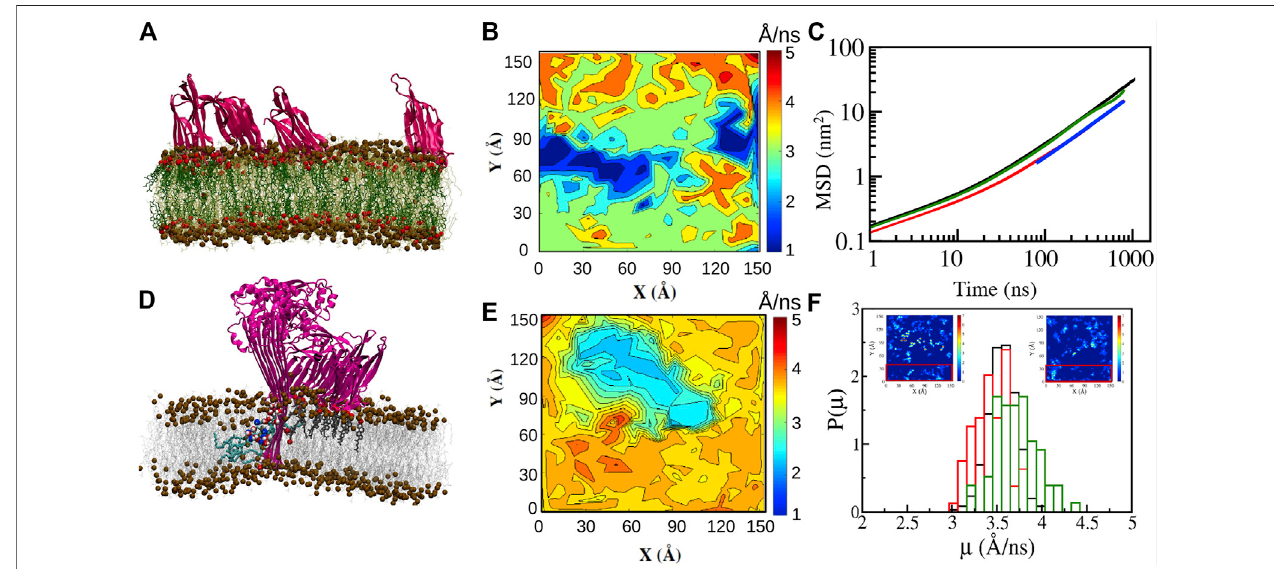
FIGURE 9 | AllatomsimulationsofLLOonDOPC:Chol(70:30)bilayers. (A) Snapshot(1 µs)offourD4membraneboundsubunits(pink).Cholesterol(dark greenwith redOHgroups),DOPC(lightgreen).DistinctcholesterolsequestrationisvisiblebelowtheD4subunits (B) MobilitymapsofthecenterofmassofDOPCmoleculeswitha Δ t (cid:1) 1 ns( Eq.4 )illustratetheloweredlipiddisplacementsintheextracellularlea fl etduetoD4bindingandcholesterol (A) sequestration. (C) MSDdatarevealsthelowereddiffusion of lipid molecules in the extracellular lea fl et. (D) Snapshot (1 µs) of the membrane inserted tetrameric LLO arc illustrates the lipids (cyan) in a toroidal conformation, cholesterol(darkgrey)boundtotheD4subunitsandthewaterchannel(oxygen — red,hydrogen — white). (E) Sameas (B) forthecytosoliclea fl et. (F) Distributionofmobilities illustrates the higher displacement for lipid molecules in regions away from the pore complex (red rectangle in the insets). The insets depict areal density of cholesterol molecules for the extracellular (left) and cytosolic (right) lea fl ets indicating cholesterol hot spots due to binding with the D4 sub unit. The units for the inset color bars are in 10 – 2 molecules/Å − 2 . Reprinted by permission from Springer Nature Customer Service Centre GmbH Springer Nature, Journal of Membrane Biology, Molecular Dynamics Study of Lipid and Cholesterol Reorganization Due to Membrane Binding and Pore Formation by Listeriolysin O, Cheerla and Ayappa (2020).